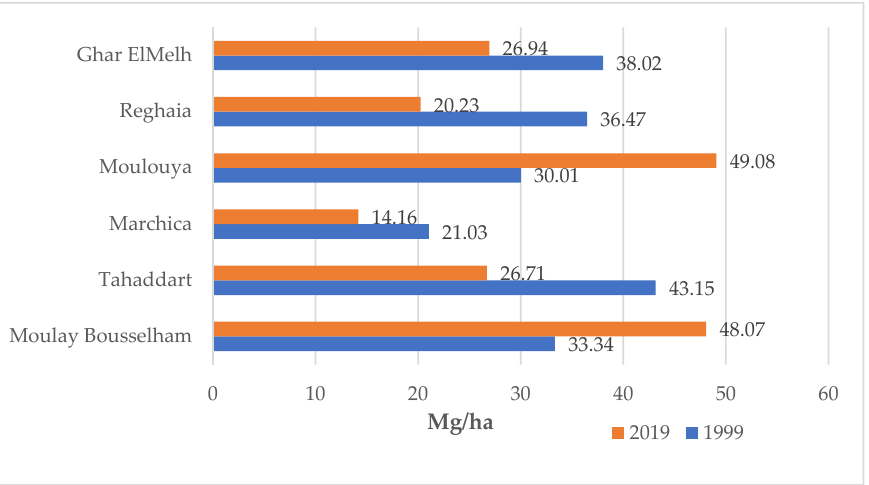
Figure 9. Estimated carbon stocks in the studied sites in response to LULC changes between 1999 and 2019 .